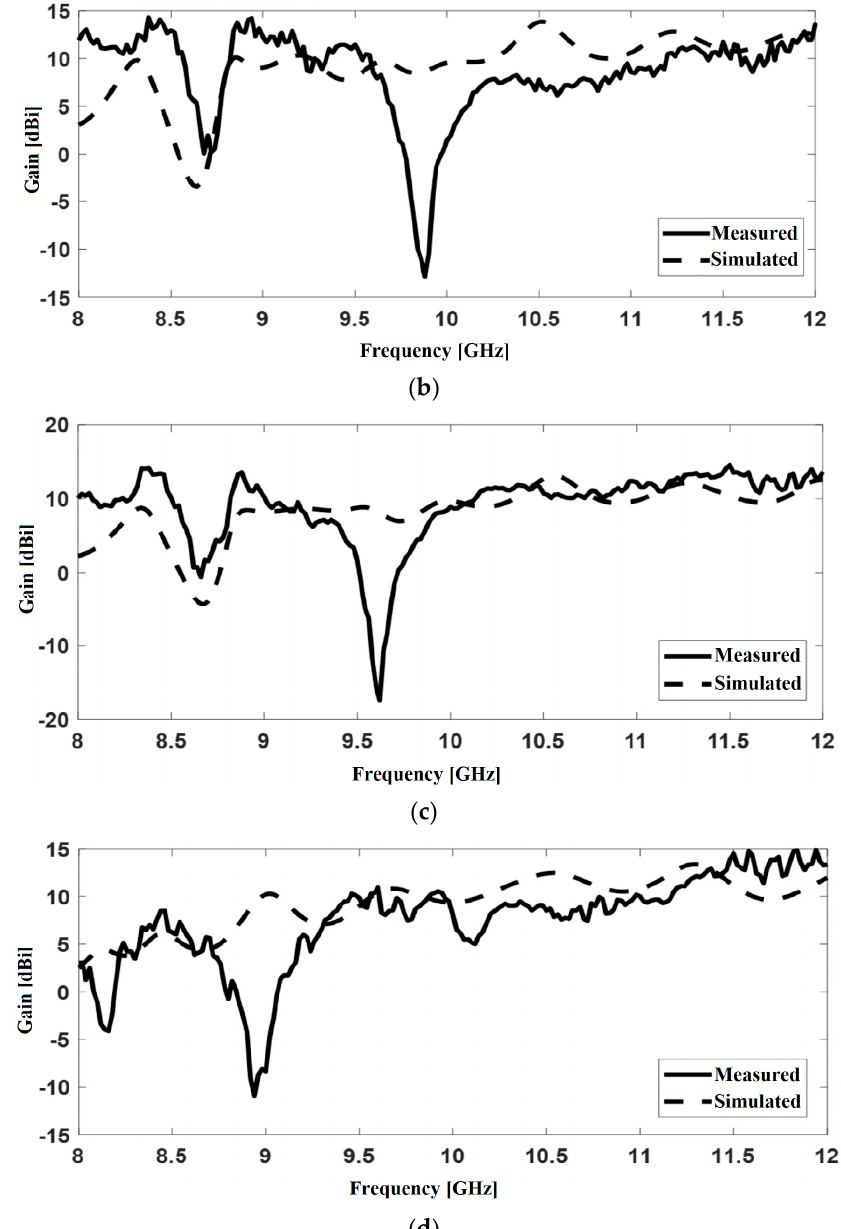
Figure 17 . Simulated and measured gain in the main direction of radiation: versions ( a – d ).